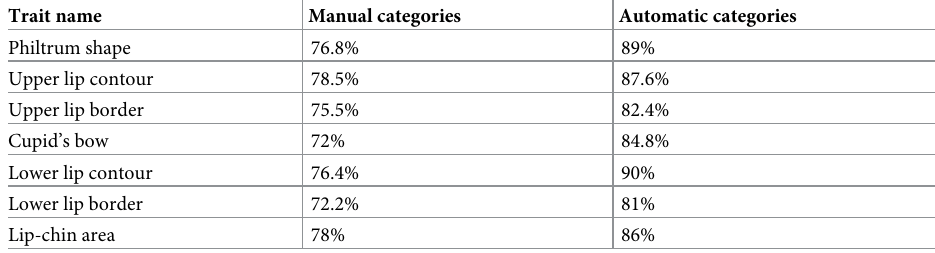
Table 9. Classification accuracies for the manual and automatic lip area trait labels.